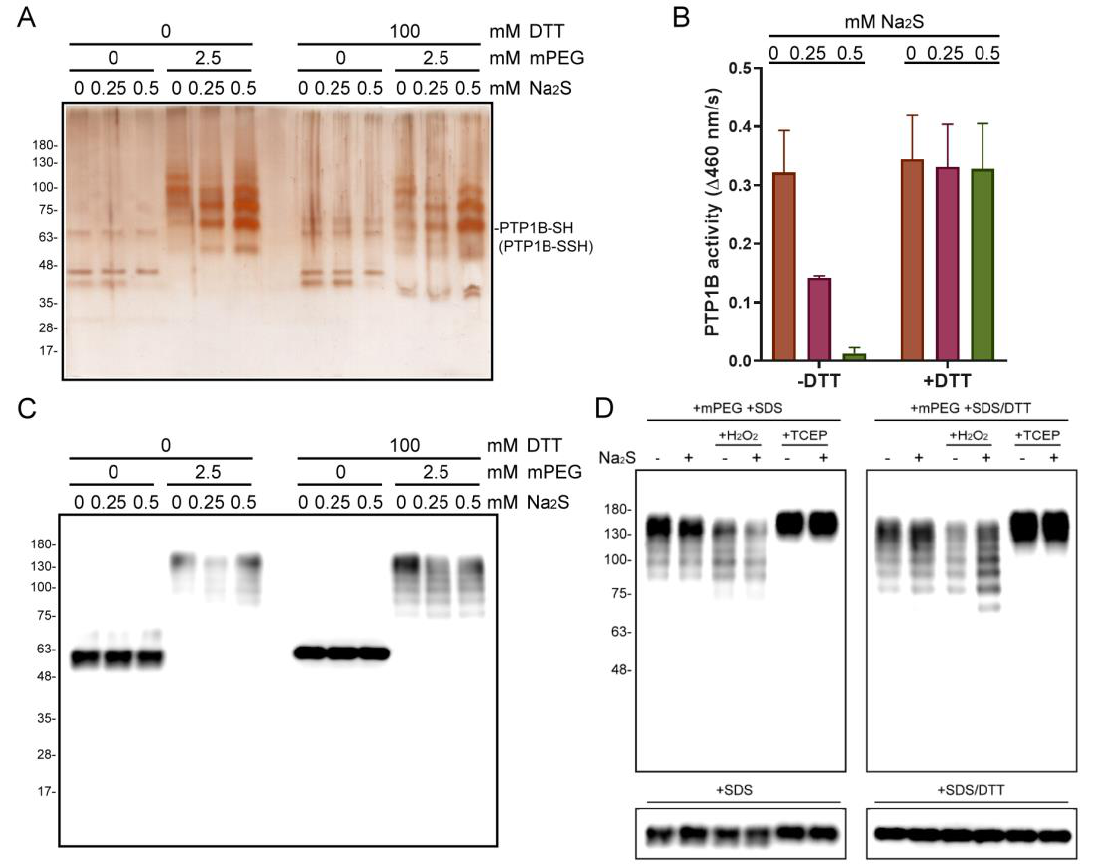
Figure 2. In vitro PTP1B S-sulfhydration. ( A ) Detection of S-sulfhydrated PTP1B in Na 2 S-treated recombinant PTP1B samples by tag-shift technique. ( B ) The related PTP1B activity of Na 2 S-treated protein samples. ( n = 3). ( C ) Detection of S-sulfhydrated PTP1B in Na 2 S treated HEK293T cell lysates. ( D ) Detection of S-sulfhydrated PTP1B in Na 2 S-treated HEK293T cell lysates with pre-treatment of H 2 O 2 or TCEP.